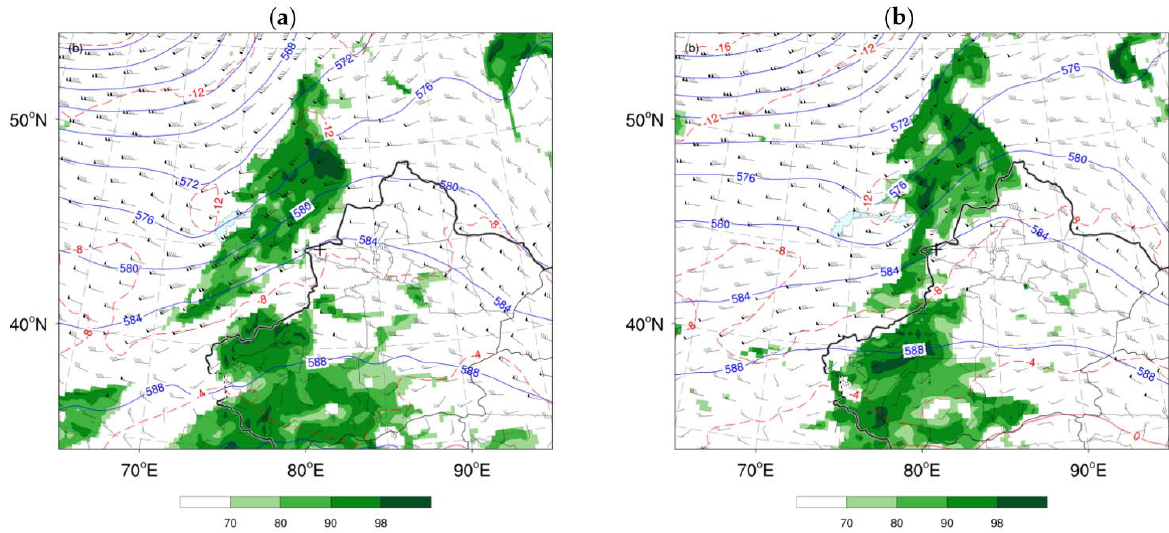
Figure 5. Environmental conditions with the geopotential height (unit gpm, blue lines), wind vector (unit m/s, wind bars), temperature (unit °C, red lines) at 500 hPa, and relative humidity (unit %, colour shades) at 750 hPa at ( a ) 0000 UTC, ( b ) 0600 UTC 30 July 2019 from